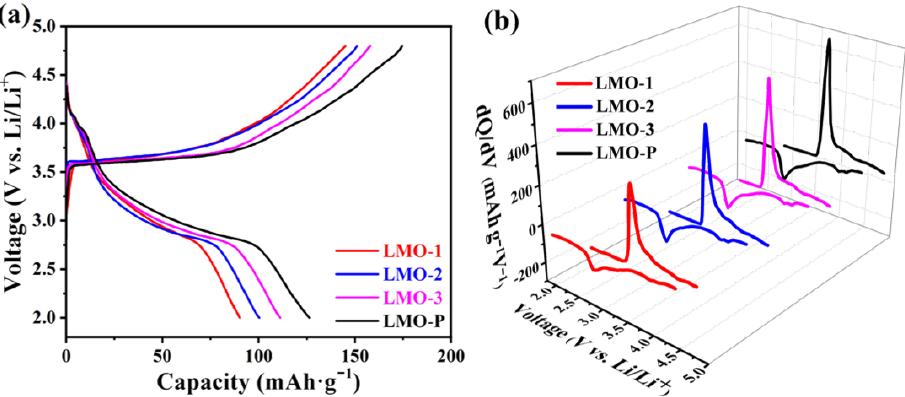
Figure 5. The charge/discharge profiles of the various samples in the first cycle ( a ) and the corre- sponding dQ/dV curves ( b ).